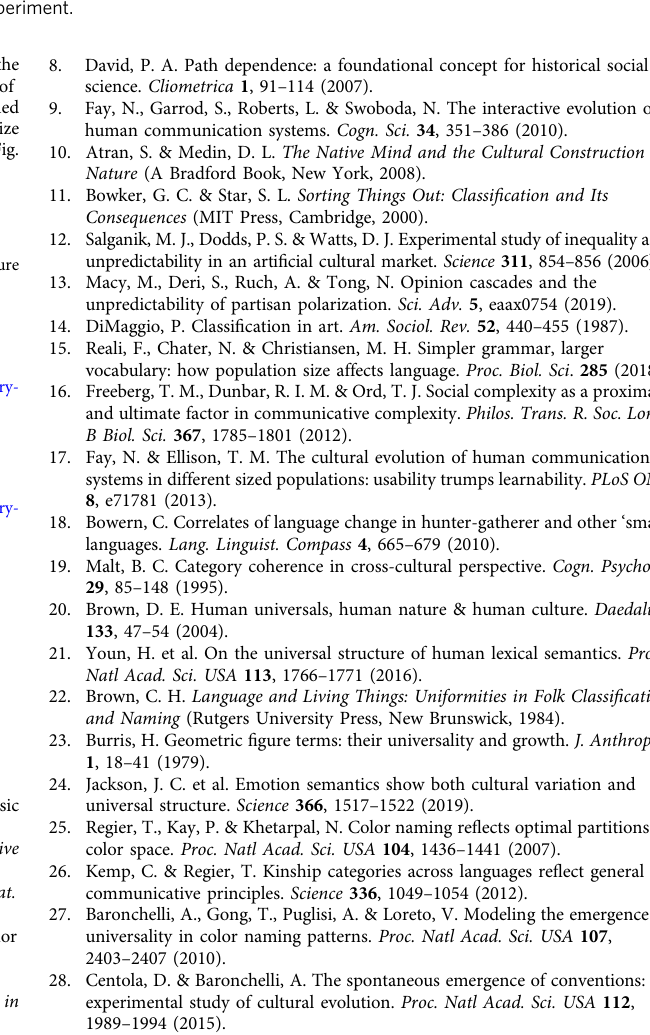
Fig. 5 The Grouping Game. Screenshots of “ The Grouping Game ” interface from the view of a speaker ( a ) and the view of a hearer ( b ) on a given round. c A sample of the continuum of novel shapes used as stimuli in the